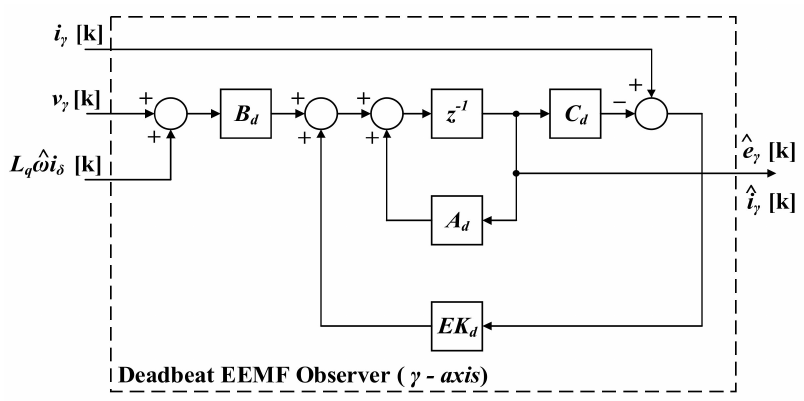
Figure 3. Block diagram of DEEMFO.